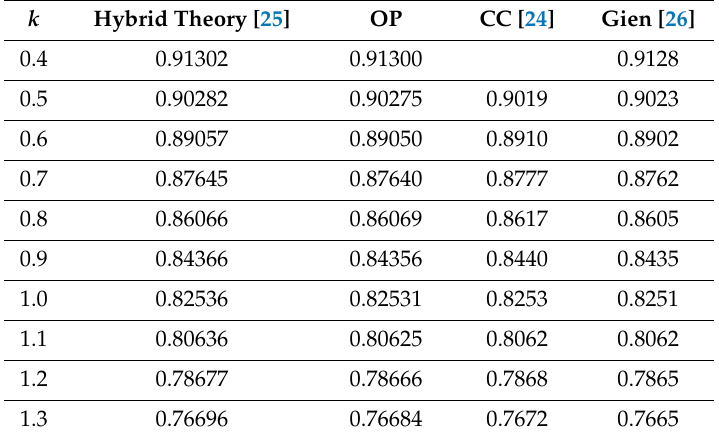
Table 4. Comparison 3 S phase shifts (radians) for electron—He + scattering with those obtained using OP [28], CC [26], and obtained by Gien [26] using the Harris–Nesbet method.